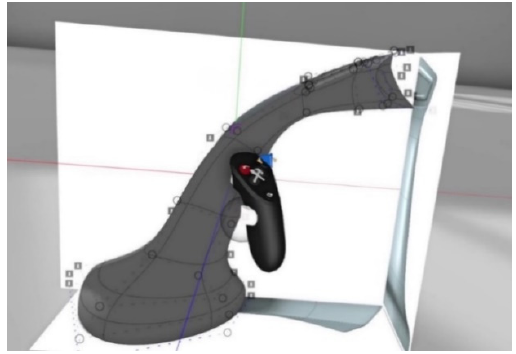
Figure 6. Still from a video showing the creation of an example model in a VR environment.